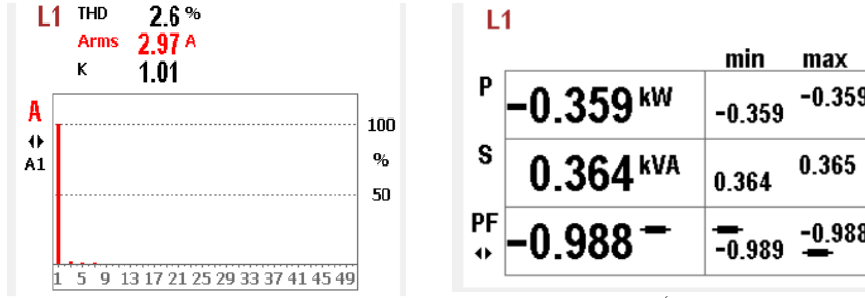
Figure 16. Measured THD and harmonic spectra, and PF when the PV injects energy.